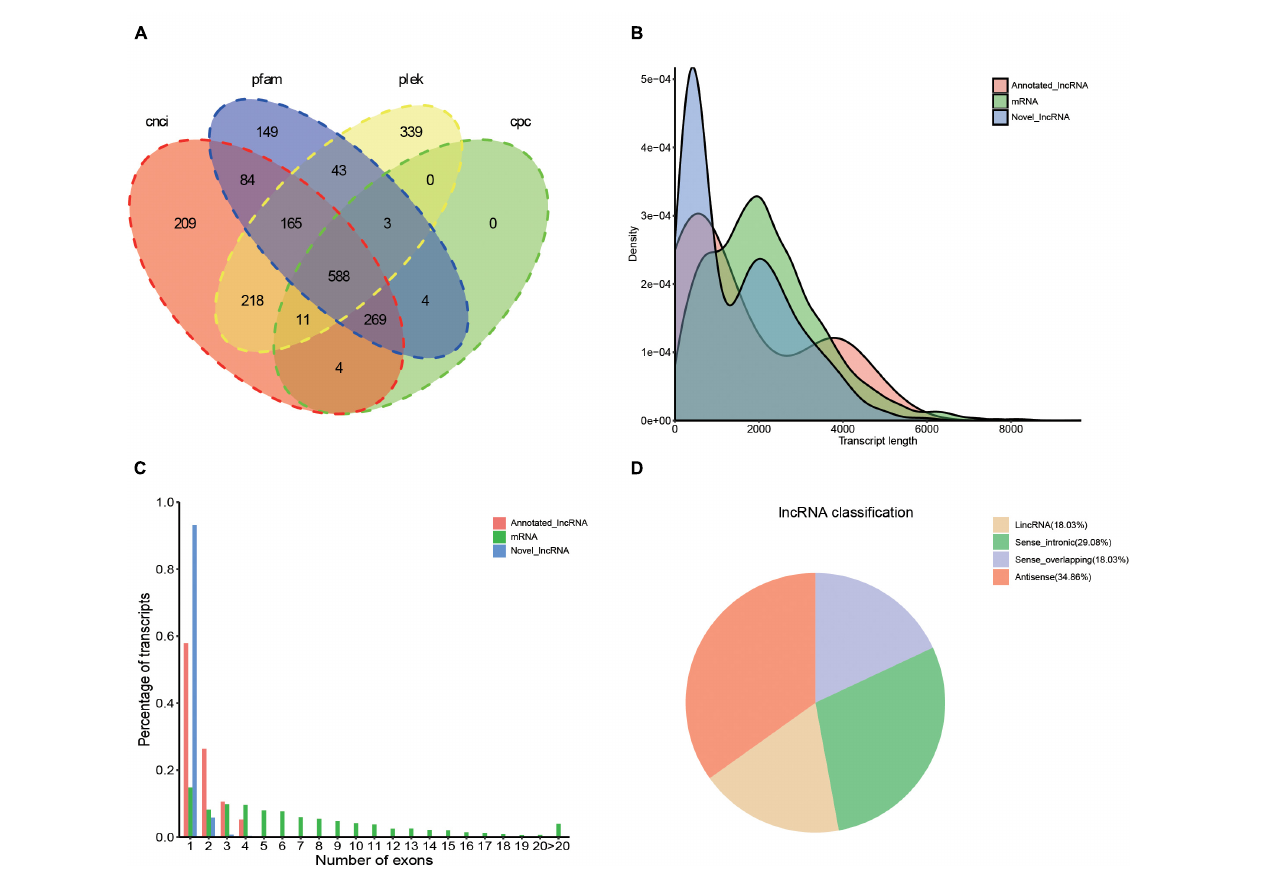
FIGURE 6 | Identification of lncRNA based on the SMRT sequencing. (A) Venn diagram of lncRNA predicted by CNCI, CPC, PLEK, and Pfam tools. (B) Length and density distribution of annotated lncRNA, novel lncRNA, and mRNA identified. (C) Comparison of exon number of annotated lncRNA, mRNA, and novel lncRNA. (D) Classification of the types of